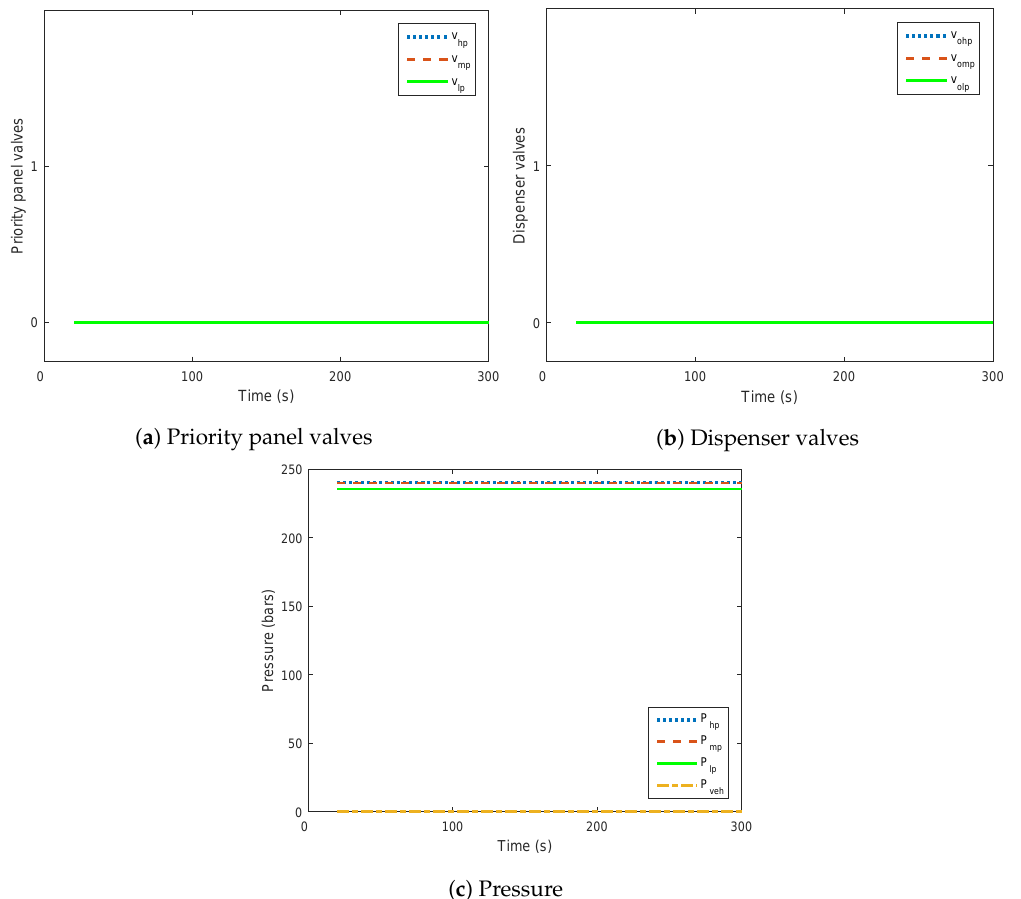
Figure 10. Profile with compressor off and no vehicle at the